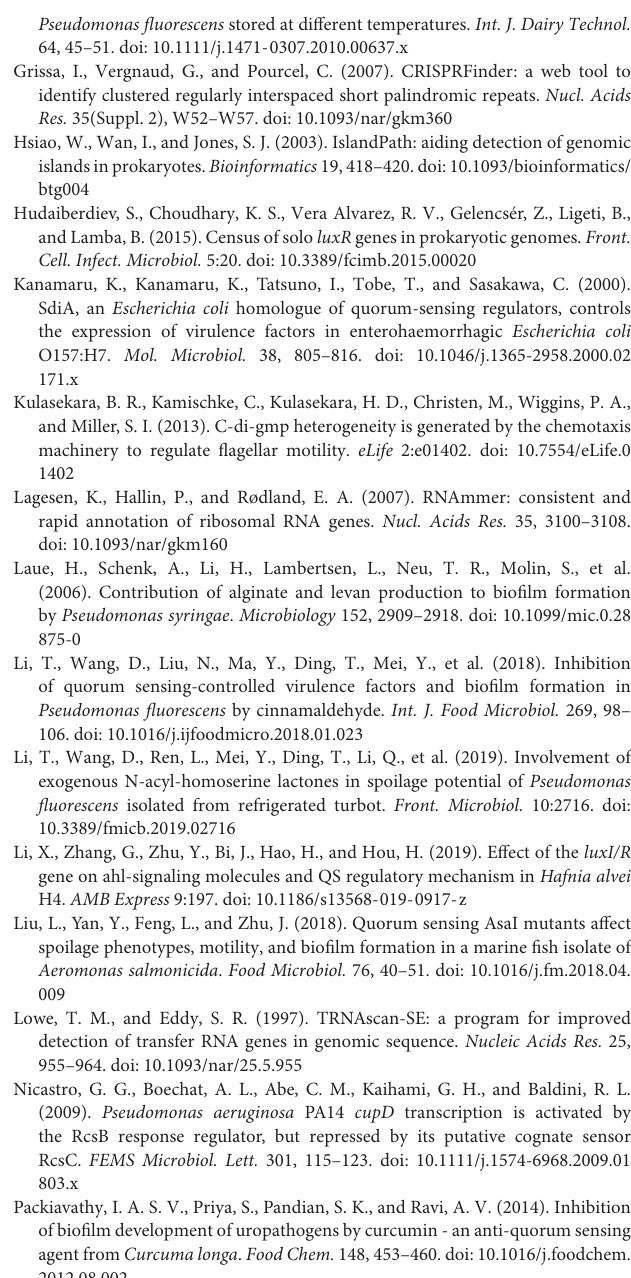
Supplementary Figure 1 | Alignment of the genomes of Pseudomonas fluorescens PF08 and different type strains of other Pseudomonas . P. fluorescens UK4 (A) , P. aeruginosa PA01 (B) , P. putida NBRC 14164 (C) , P. syringe BIM B-268 (D) . The same color represents the colinear regions of similarity. Supplementary Figure 2 | The inhibitory effect of ethyl acetate extract of Pseudomonas fluorescens PF08 on the growth of Staphylococcus aureus and Aeromonas salmonicida CS12. (a) Metabolites of PF08; (b) Equal amount of 50% (v/v) methanol used as